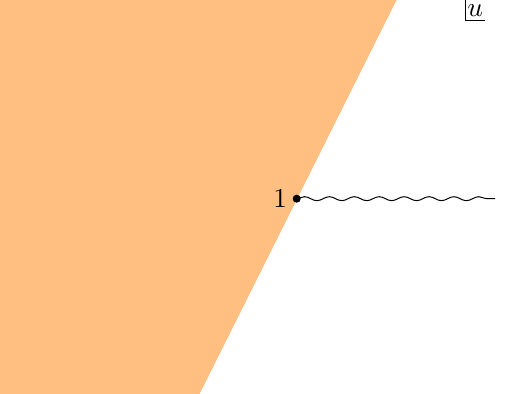
Figure 14 . The con(cid:12)guration which de(cid:12)nes the (cid:26) -coordinates for the correlator h O 1 ;L O 2 ;L O 3 ;R i The defect is a sphere with unit radius, and the points 1 and 2 are aligned with its center, both at distance r < 1 from it. The right operator lies at distance R (cid:21) 1 from the center of the spherical defect. The (cid:26) -coordinates are the complex coordinates of the operator O 1 ;L , (cid:26) = re i (cid:18) , together with the positive real parameter R .